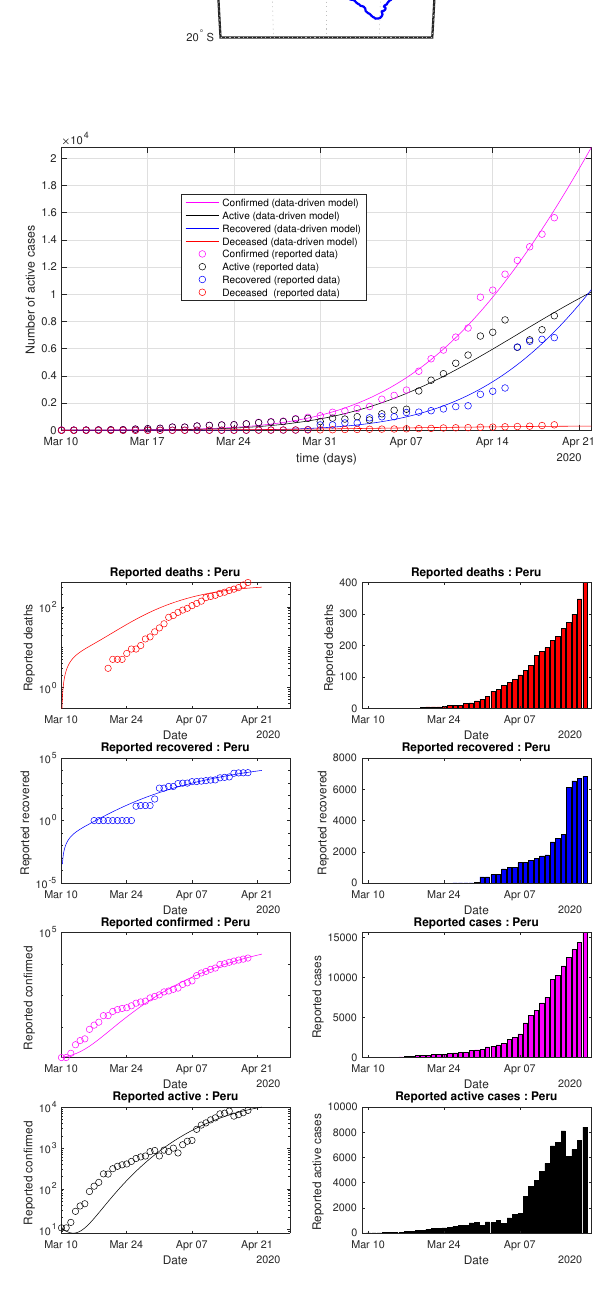
Figure 27. Peru: data of active, recovered, deceased (in circle or bar) vs. model of active, recovered, deceased over time. Tracking the number of active cases. Predictive analytics for the next couple